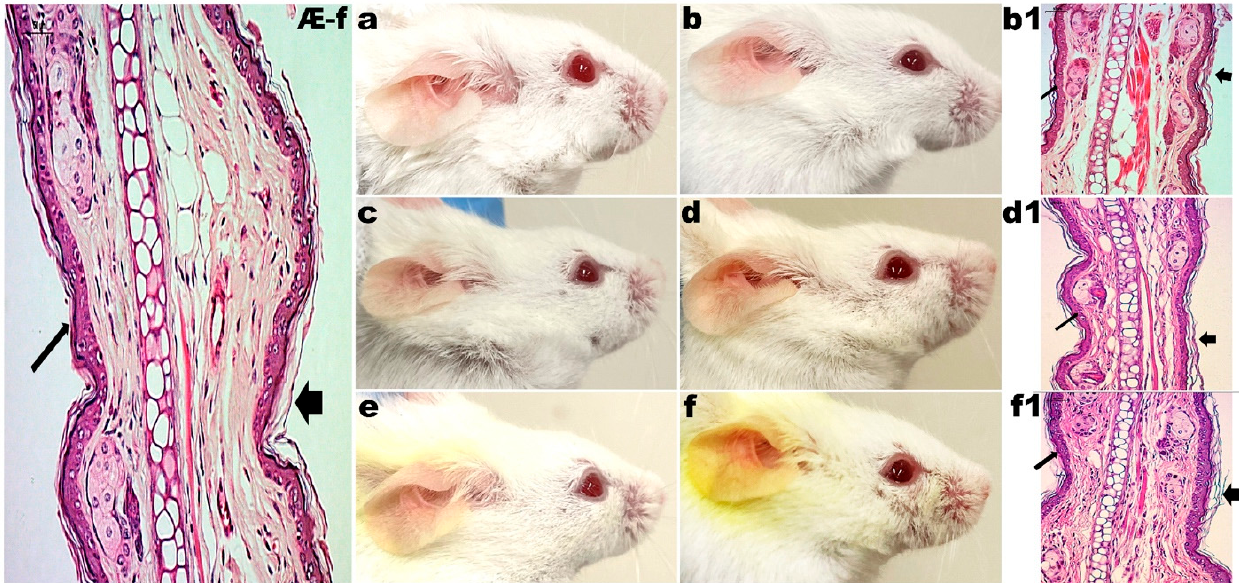
Figure 3. Results obtained after application of the formulations in the ears of female mice. ( a ) (G2) 10 days of LBG (2%, w/w ) gel application; ( b ) (G2) 20 days of LBG (2%, w/w ) gel application; ( c ) (G3) 10 days of application of LBG gel (2%, w/w ) with CUR (2%, w/w ); ( d ) (G3) 20 days of application of LBG gel (2%, w/w ) with CUR (2%, w/w ); ( e ) (G4) 10 days of application of LBG gel (2%, w/w ) with CUR (2%, w/w ) and CAGE-IL (2%, w/w ); ( f ) (G4) 20 days of application of LBG gel (2%, w/w ) with CUR (2%, w/w ) and CAGE-IL (2%, w/w ); ( Æ - f ) (G1) photomicrograph (×200 magnification) of histo- logical section of mouse ear skin of female absolute control; ( b1 ) (G2) photomicrograph (×200 mag- nification) of histological section of mouse ear skin after 20 d of application of LBG gel (2%, w/w ); ( d1 ) (G3) photomicrograph (×200 magnification) of histological section of mouse ear skin after 20 d of application of LBG gel (2%, w/w ) with CUR (2%, w/w ); ( f1 ) (G4) photomicrograph (×200 magnifi- cation) of histological section of mouse ear skin after 20 d of application of LBG gel (2%, w/w ) with CUR (2%, w/w ) and CAGE-IL (2%, w/w ). The histological sections were stained with hematoxylin and eosin. For the significance of inserted (thick, thin and arrowhead) arrows, please refer to the Discussion section. Scale bar represents 50 µm. Note: the yellowish color observed in the fur of the animals is due to the use of the gel with CUR and CAGE-IL, with the ionic liquid promoting a greater solubility of CUR and consequently dying the fur.